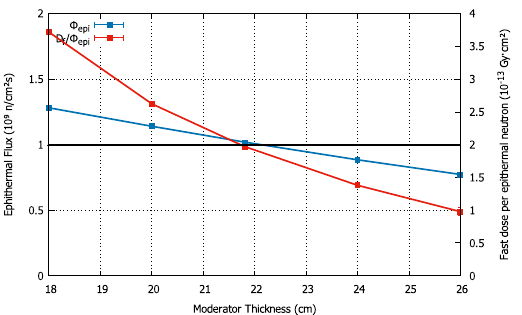
Figure 1. Optimization of the moderator thickness. The optimal value is found by keeping the epithermal flux (blue line) above the IAEA minimum recommendation (black line), while the fast dose per epithermal flux (red line) is below the IAEA maximum value recommended (same black line). This happens for a thickness of 21.8